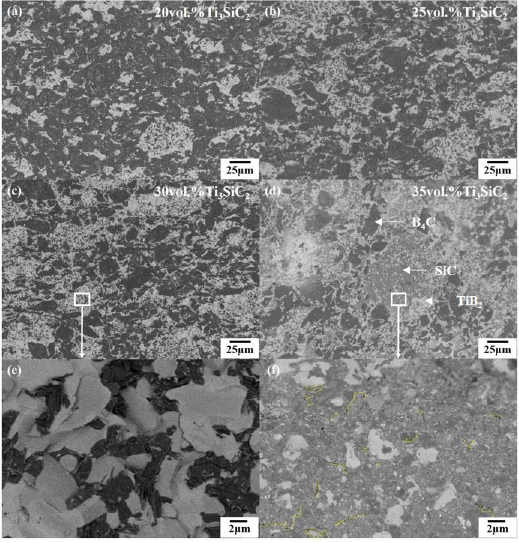
Figure 7. ( a – d ) BSE images of B 4 C–TiB 2 composite ceramics sintered with 20 vol.%, 25 vol.%, 30 vol.%, 35 vol.% Ti 3 SiC 2 in order; ( e ) Local magnification BSE image of ( c ); ( f ) Local magnification BSE image of ( d ).